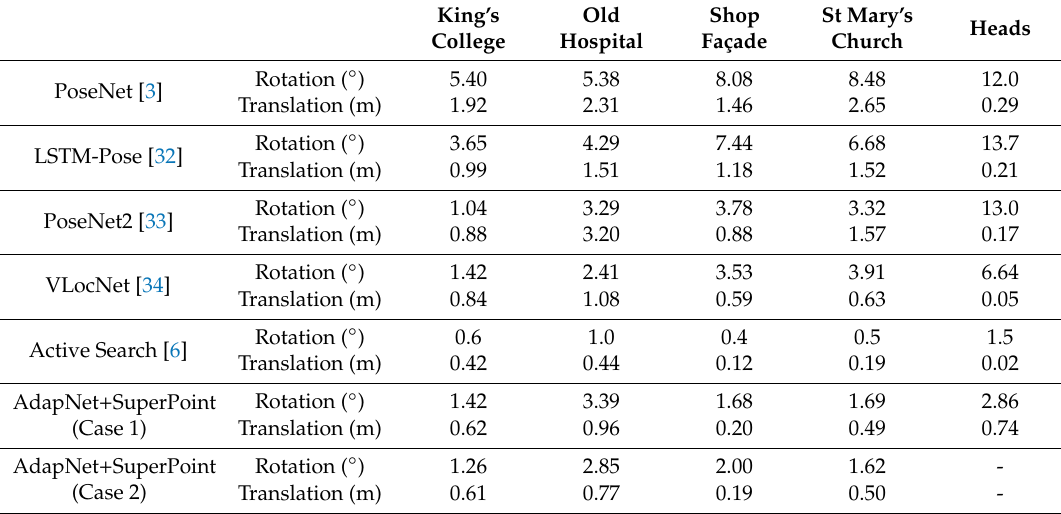
Table 3. Comparison of translation and rotation errors observed with di ff erent camera pose estimation